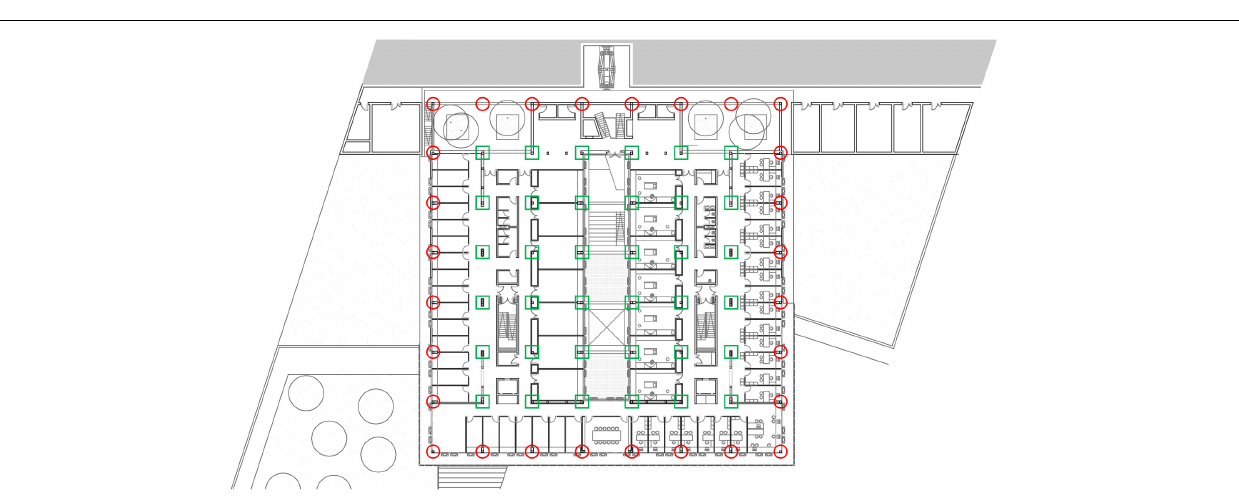
lifting for possible removing and replacement of the